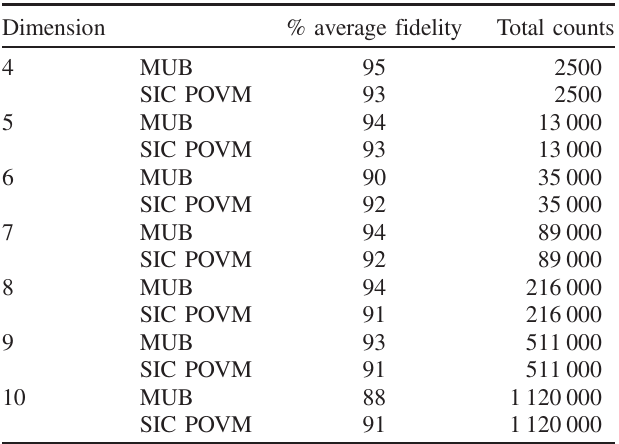
TABLE II. Counts per QST method necessary to obtain a 90% fidelity. This is obtained based on Monte Carlo simulations; see the main text for